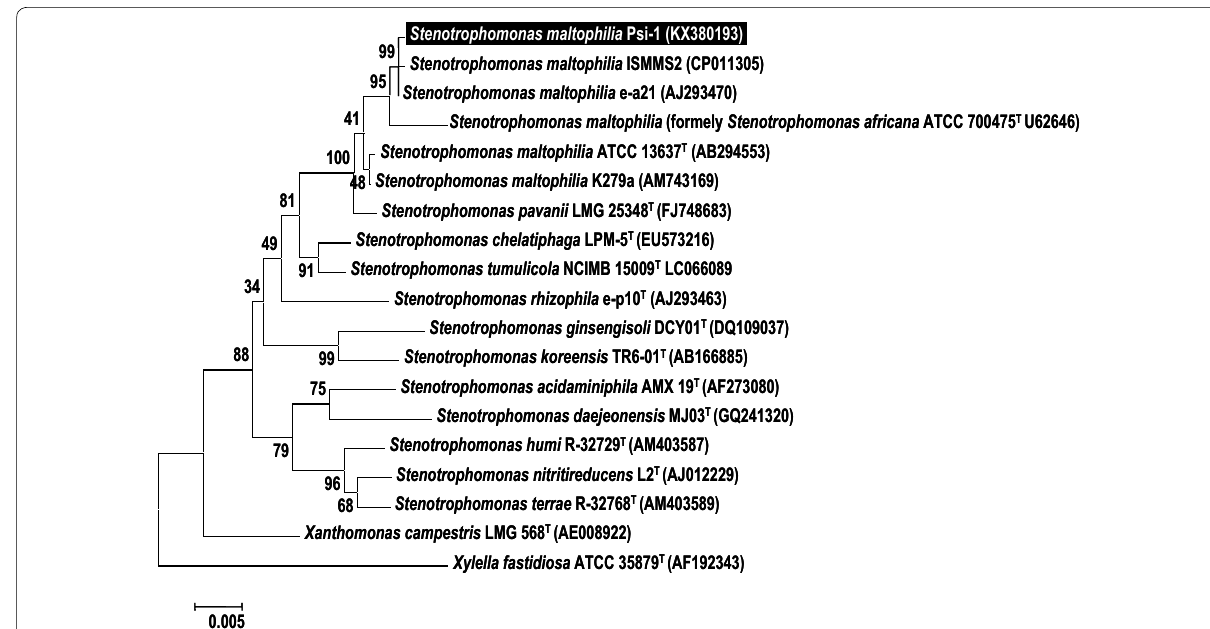
Fig. 1 Phylogenetic position of S . maltophilia Psi‑1 amongst other strains of S . maltophilia and related species. Phylogenetic analyses were conducted with algorithm MEGA. The tree was constructed with a neighbour joining algorithm using 16S rRNA gene sequences. Xylella fastidiosa served as an outgroup. The percentage of replicate trees in which the associated taxa clustered together in the bootstrap test (1000 replicates) are shown next to the branches. The scale bar indicates the number of substitutions per nucleotide